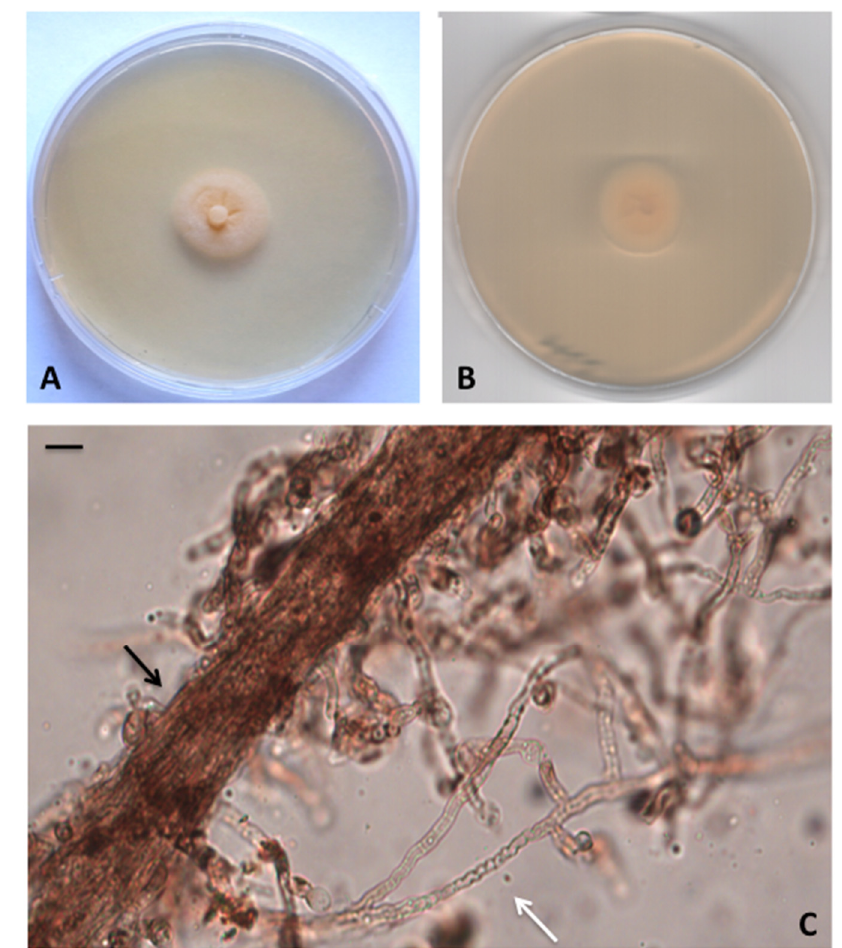
Figure 3. Parathyridaria tyrrhenica sp. nov. 28-days-old colony at 21 °C on MEASW ( A ) and reverse ( B ); mycelium ( C ), black and white arrows indicate hyphal strands and wavy hyphae, respectively. Scale bar: 10 µm.